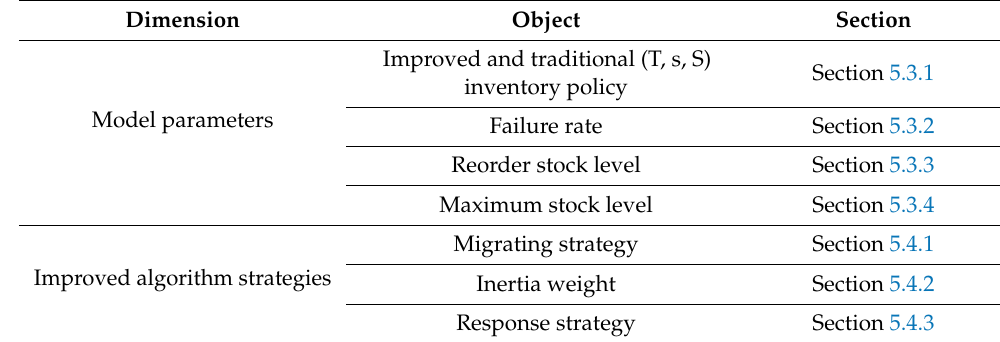
Table 3. Related works on sensitivity analyses.